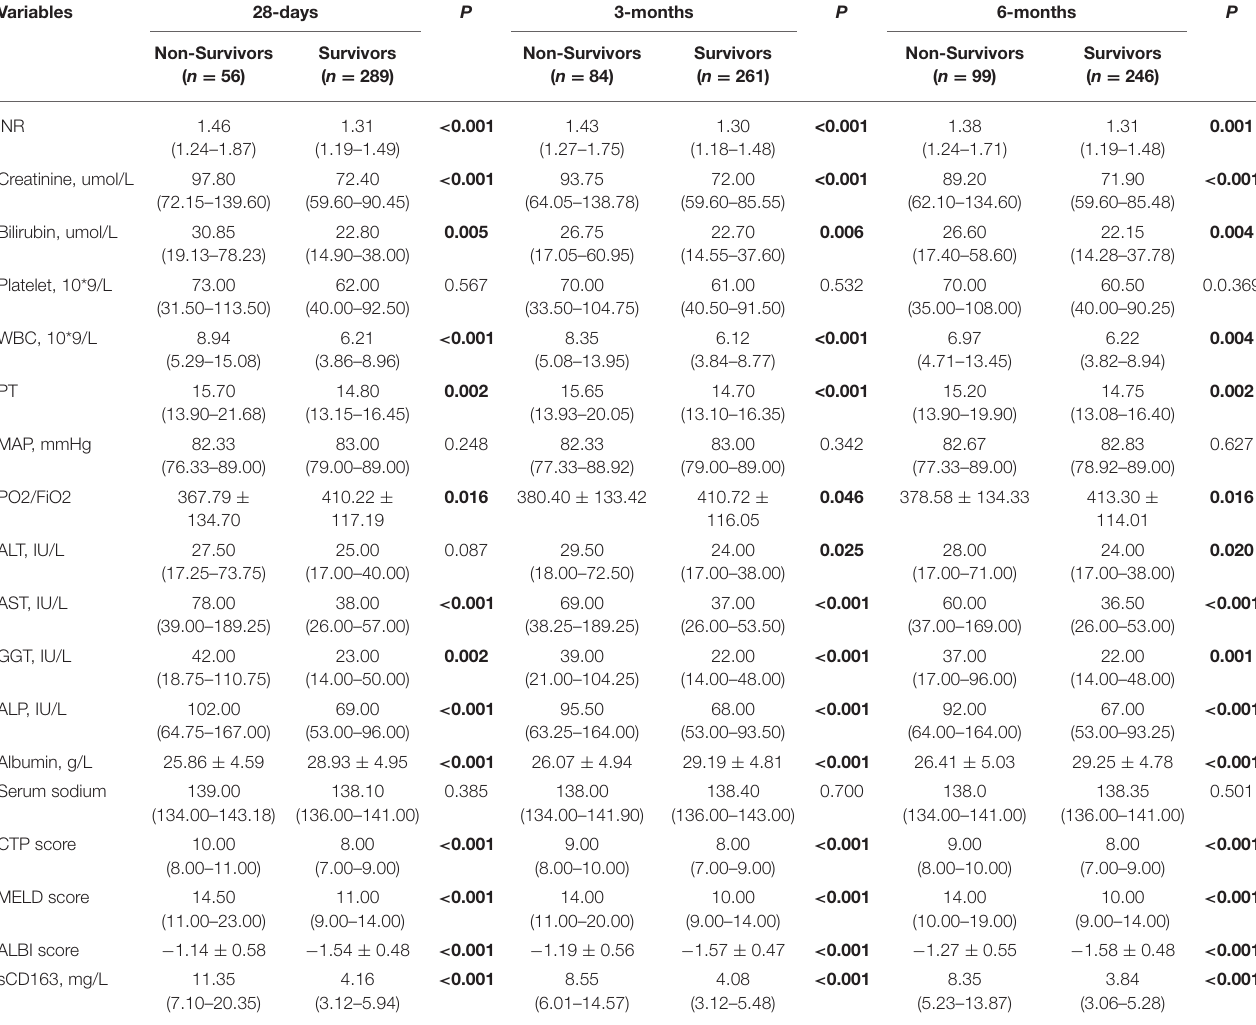
TABLE 2 | Clinical characteristics and prognostic model between non-surviving and surviving patients.